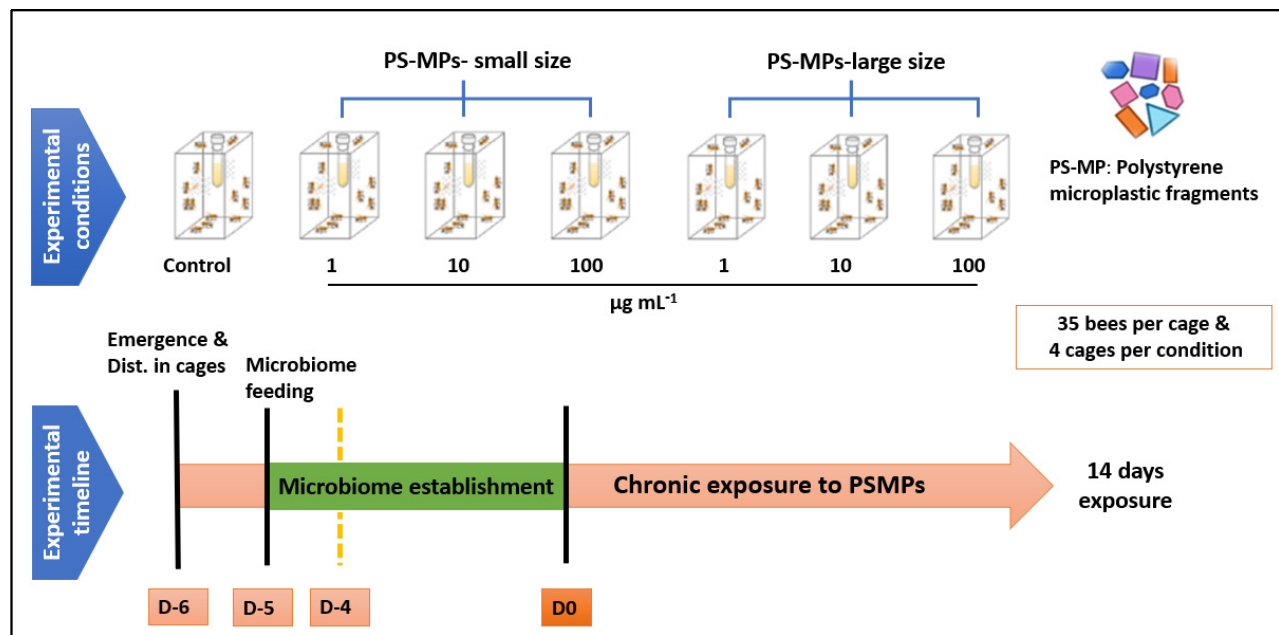
Figure 2. Experimental design. Upper row: treatments (four cages per treatment); lower row: timing of microbiome establishment (D-5), PS-MPs treatment (D0).